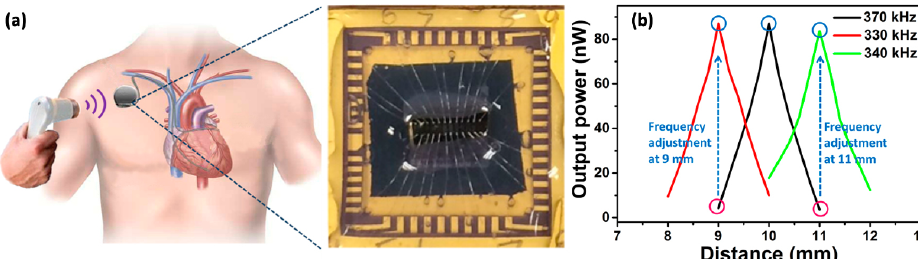
Figure 8. ( a ) Ultrasonic energy harvester integrated with a pacemaker; the fabricated chip is shown at the right side. ( b ) Frequency adjustment for achieving high transfer power and efficiency due to breathing and muscle movement for a 1 mm fluctuation in distance. Reprinted from